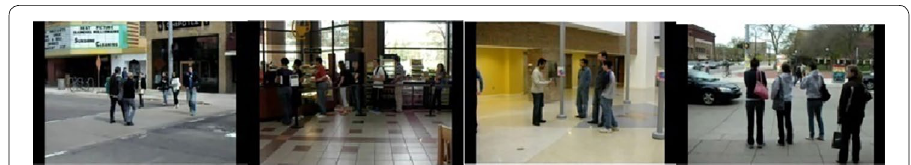
Fig. 9 Collective human actions (crossing, queuing, talking, waiting)